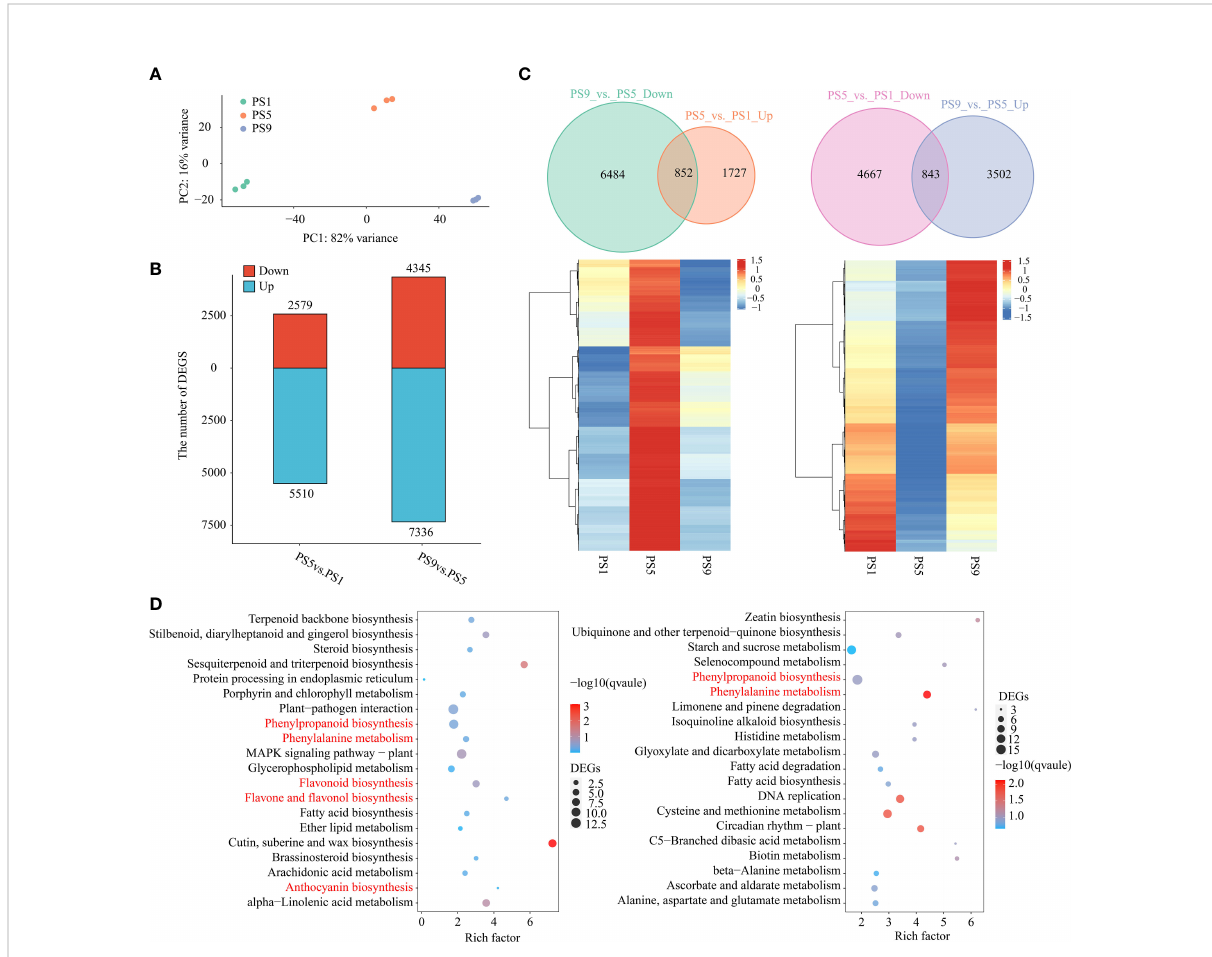
FIGURE 2 Comparative transcriptome analysis of red apple fruits at three different ripening stages. (A) PCA analysis result of red apple transcriptome data for PS1, PS5 and PS9; (B) Number of differentially expressed genes; (C) Venn diagram and heatmap of DEGs up-regulated in PS5_vs_PS1 but down-regulated in PS9_vs_PS5 (left) and DEGs down-regulated in PS5_vs_PS1 but up-regulated in PS9_vs_PS5 (right); (D) KEGG enrichment analysis of DEGs showing the same pattern of changes in anthocyanins (left) and fl avonols (right) accumulations during fruit